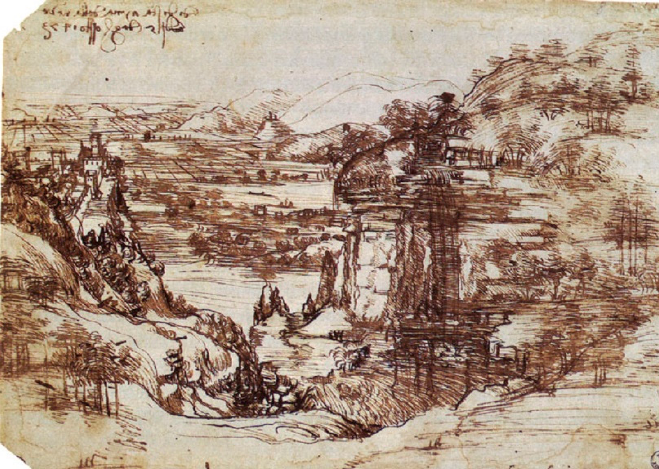
Figure 3. Leonardo da Vinci—Study of a Tuscan Landscape (1473).